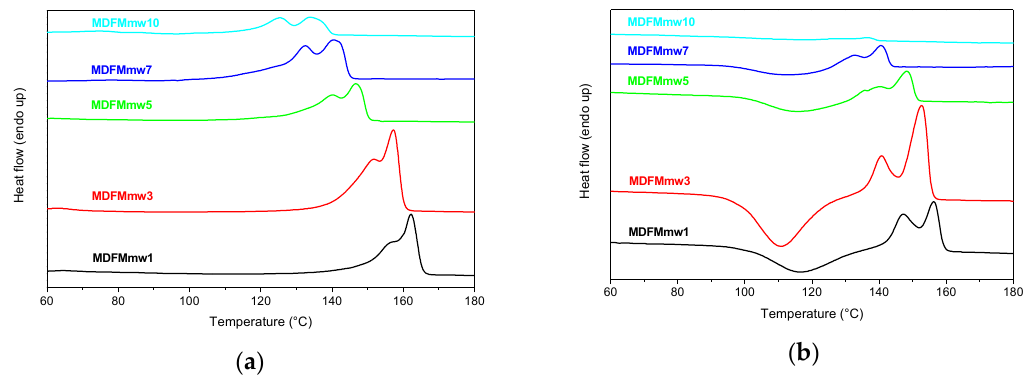
Figure 14. DSC curves of first heating ( a ) and second heating ( b ) scans of samples MDFMmw1–MDFMmw10: Heating and cooling scans were carried out at 20 ◦ C / min. The curves are vertically shifted for clarity.